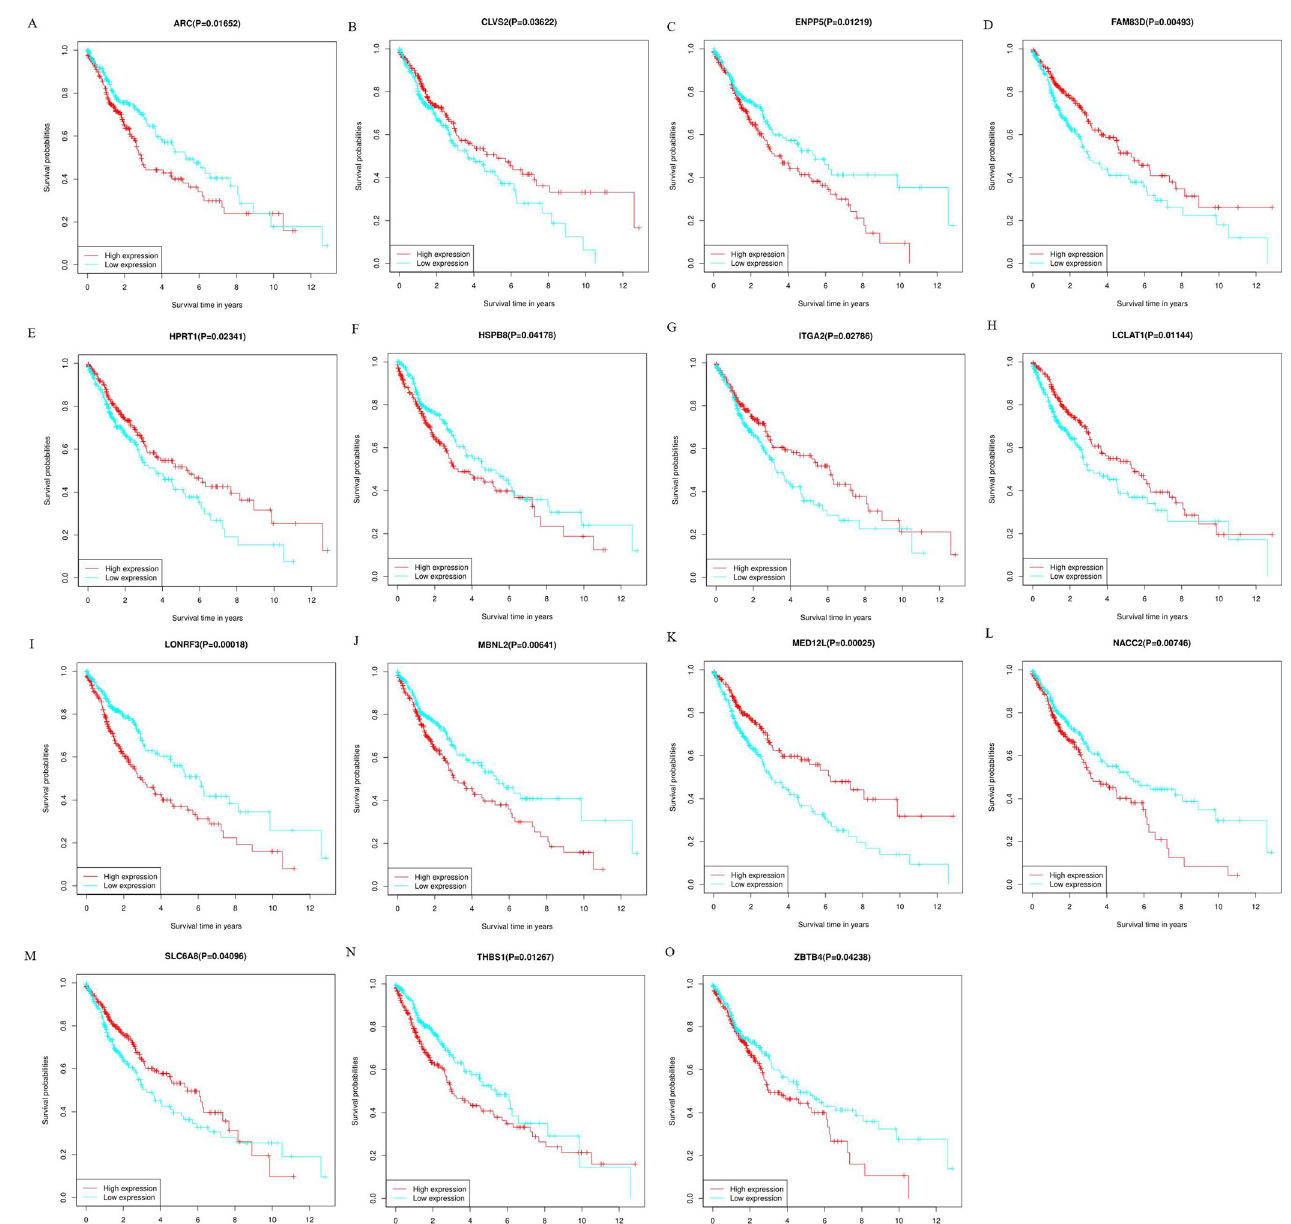
Fig 10. Overall survival analysis of the identified target genes and the protein-protein interaction (PPI) network. A-O: